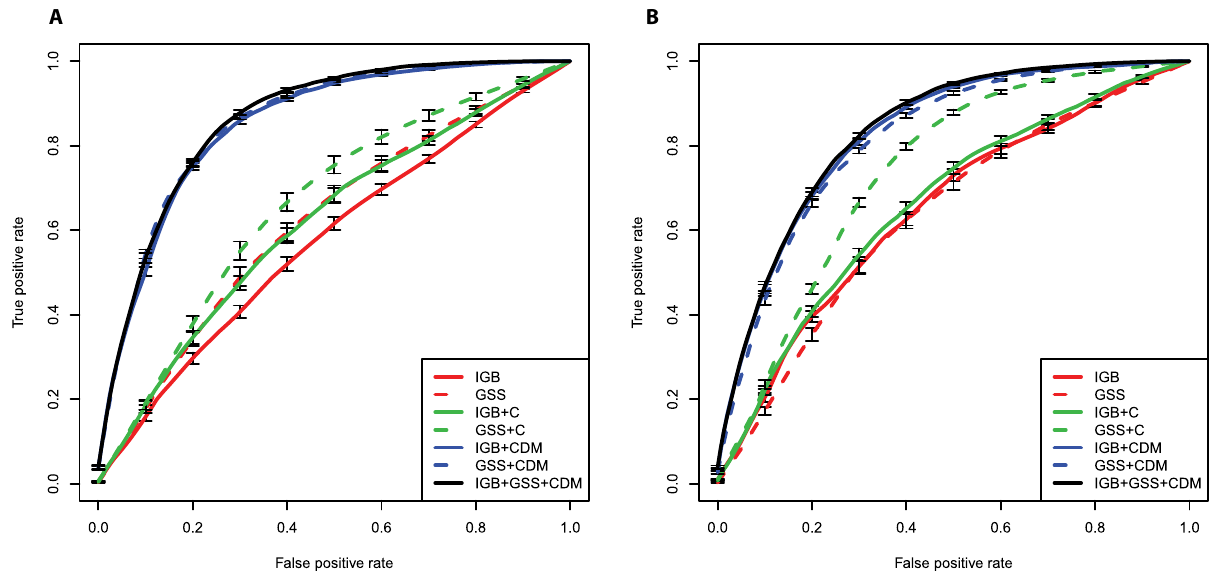
Figure 4. ROC curves quantifying the performance of elastic net regularized logistic regression models in predicting treatment outcome, defined as a reduction of viral load below 50 cps/ml (A) and 400 cps/ml (B). The areas under the ROC curves (AUC values) are reported in Table S5 and Table S6. Prediction models are encoded by the sets of predictors used, where C refers to the demographic and clinical variables, D refers to drugs, and M to mutations. For example, the model IGB + CDM includes as predictors IGB to regimen, clinical and demographic predictors, applied drugs, and mutations. The models with all predictors perform significantly better than all other models.